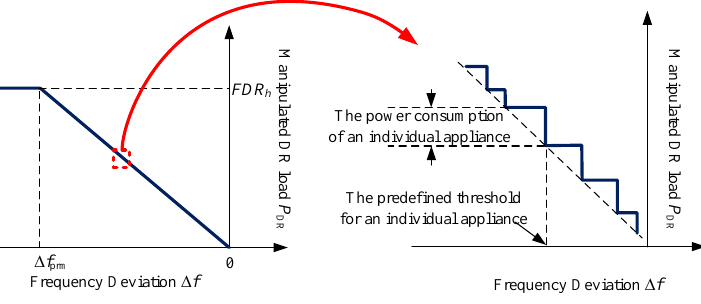
Figure 4. The frequency response characteristic of DR.